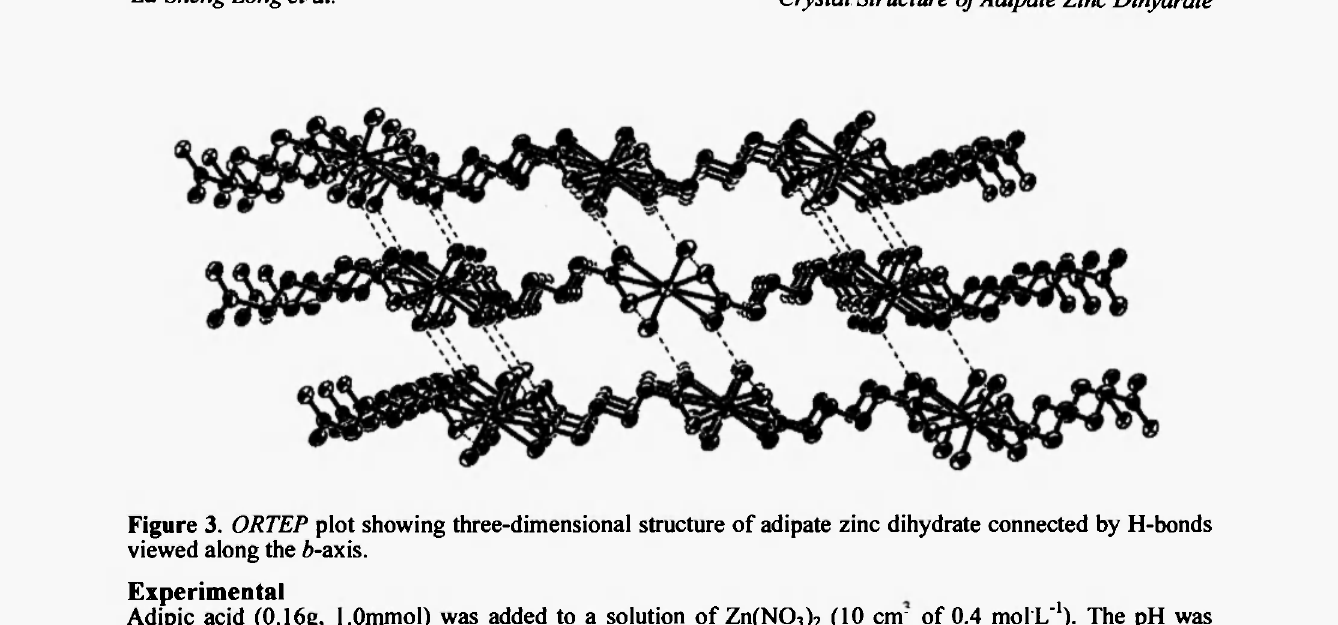
Table 1. Crystal data for adipate zinc dihydrate